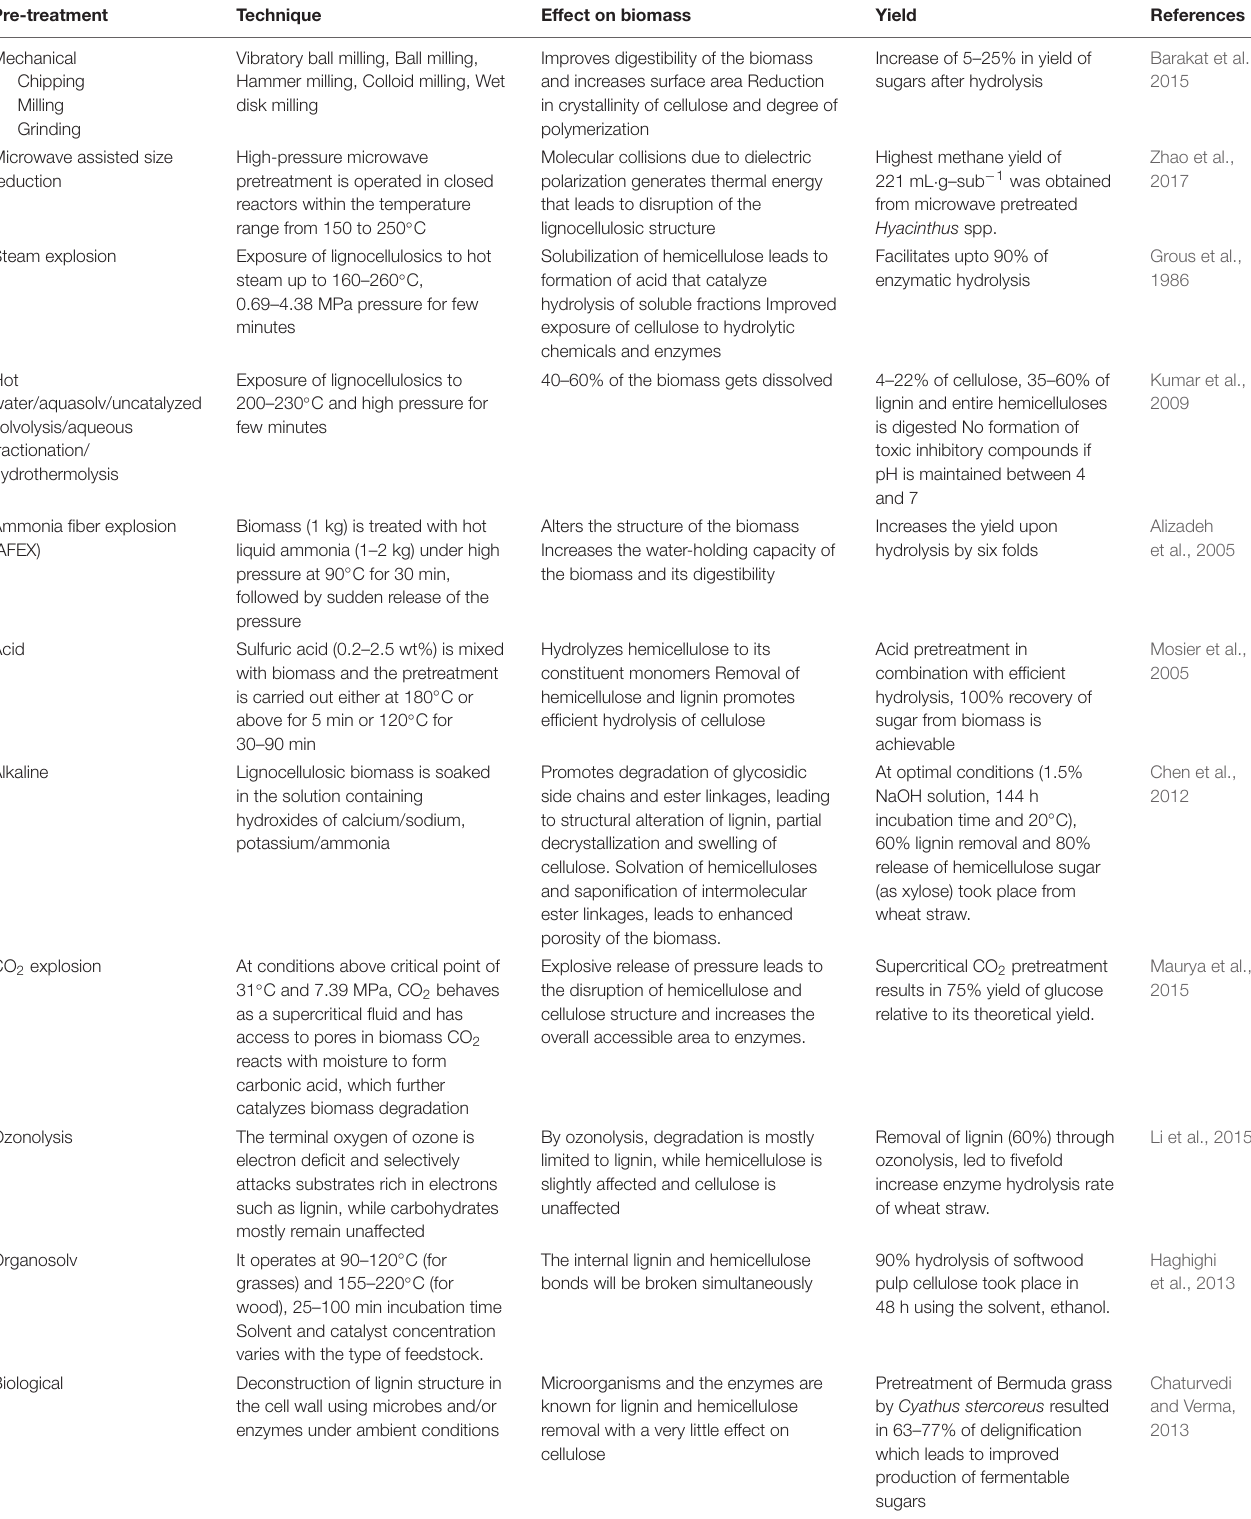
TABLE 5 | Various methods of pretreatment and their effect of the lignocellulosic